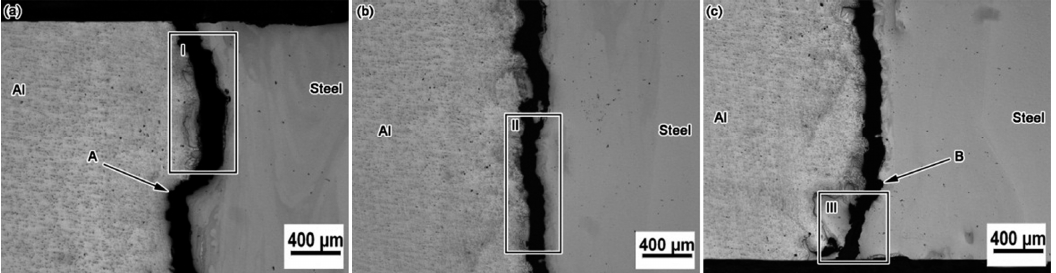
Figure 14. Fracture path of the interface at the steel/Al alloy butt joint: ( a ) top position ( b ) middle position ( c ) bottom position.